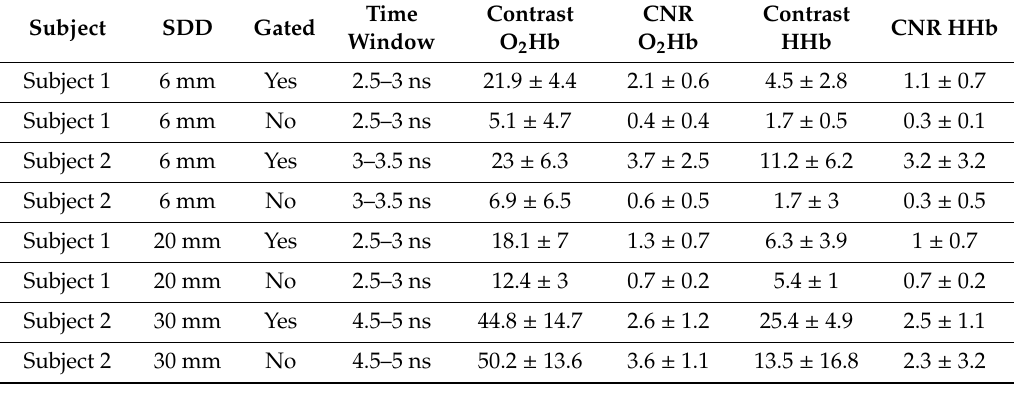
Table 1. Summary of the in vivo measurements—finger tapping with the controlateral hand. Error for contrast and CNR is the standard deviation over the 5 finger tapping task repetitions.